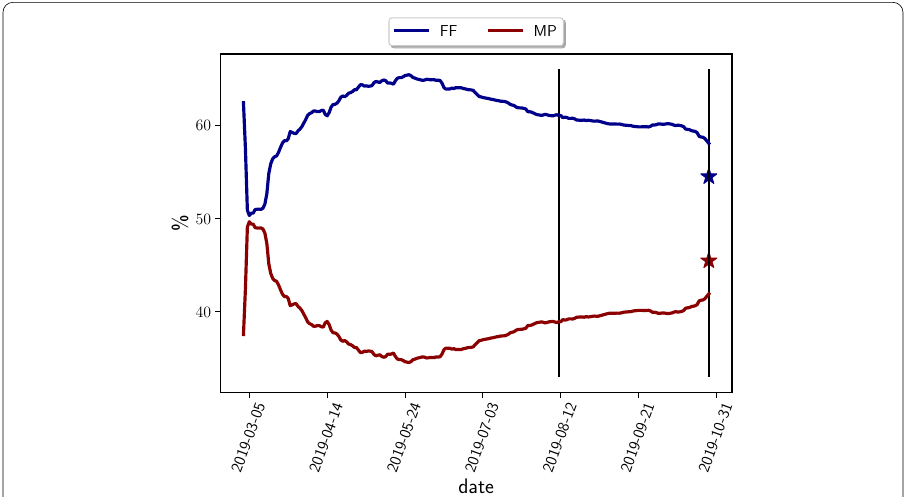
Fig. 11 Results of the cumulative Model 0 defined without considering the loyalty